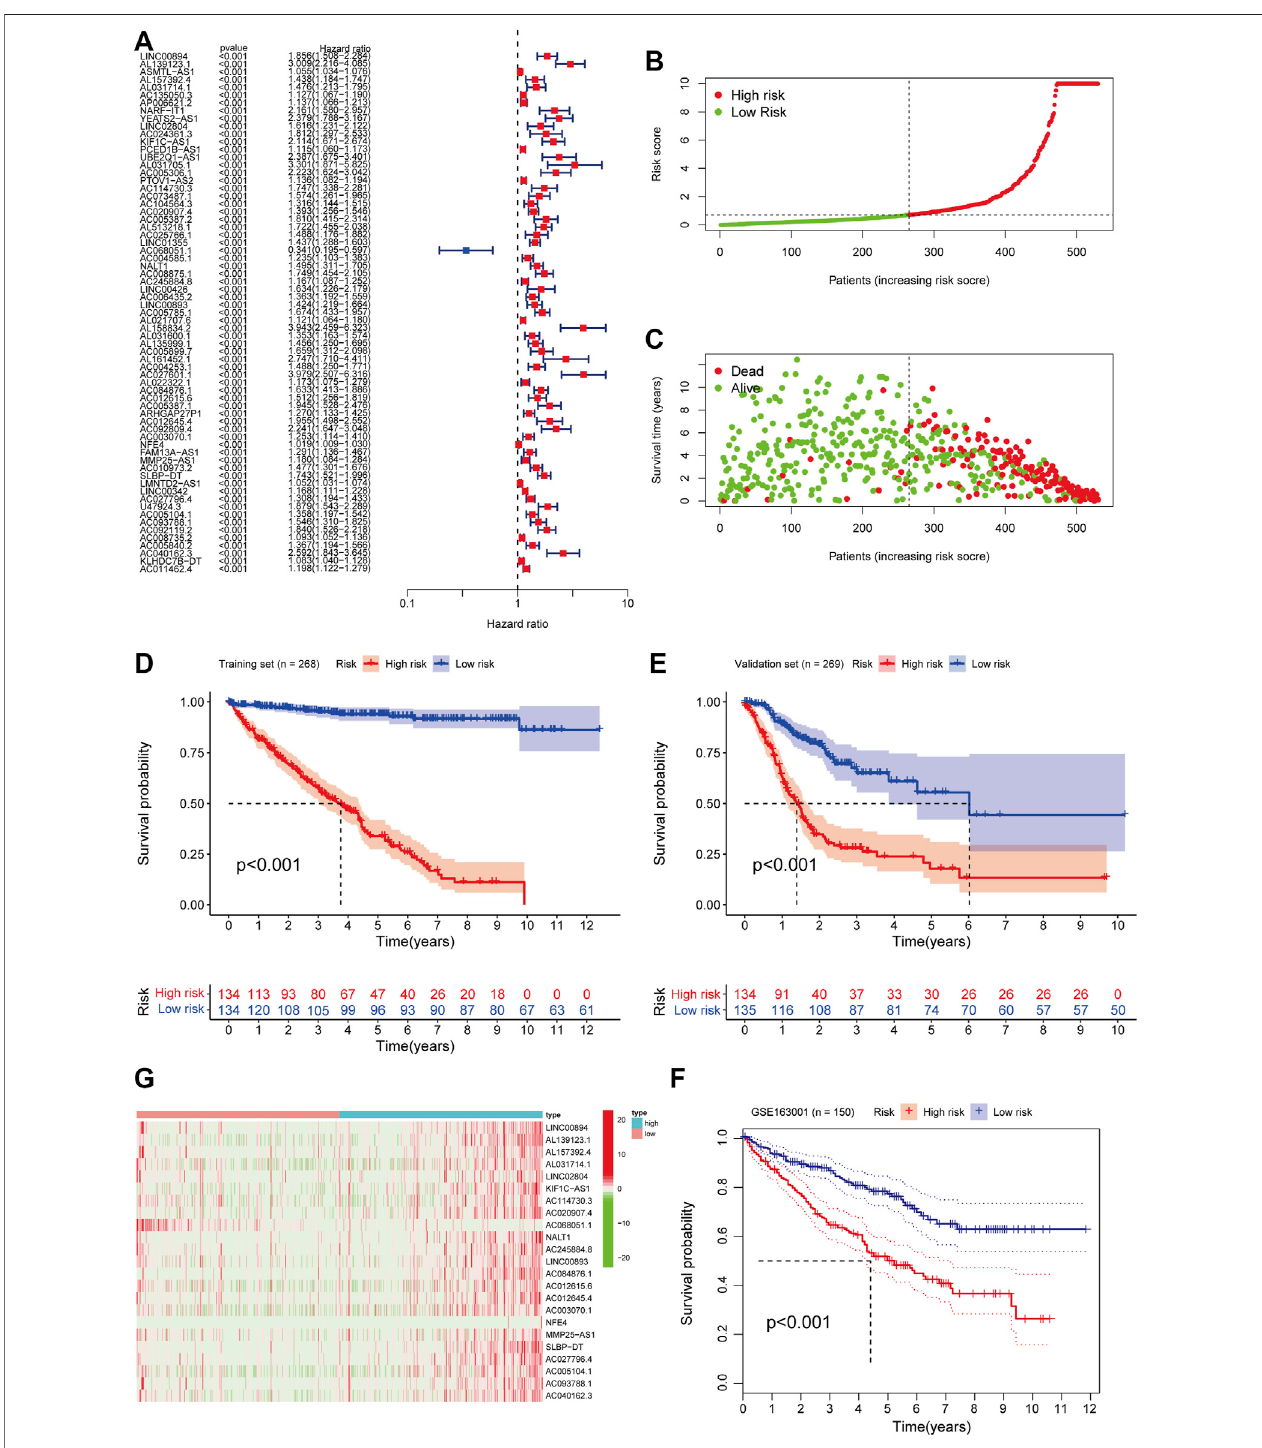
FIGURE2| Construction and validationofFRLs Prognostic Signaturein ccRCC patients. (A) Univariate Coxregressionanalysisshowed thatFRLswererelated to theOSofccRCCpatients. (B) Thedistribution ofriskscoresforthehigh-riskandlow-riskgroupsinccRCCpatients. (C) TheScatterplotsoftheOSinlower-riskccRCC patients and high-risk groups. (D) Survival curve of the high- and low-risk groups in the training set ( n = 268). (E) Kaplan-Meier survival curve of validation set ( n = 269) comparingthehigh-andlow-riskgroups. (F) Kaplan-MeiersurvivalcurveanalysisintheindependenttestsetGSE163001( n =150)comparingtworiskgroups. (G) Heatmap of clinical correlation of FRLs in ccRCC. All the K-M survival analyses use log-rank tests to determine signi fi cant differences between two groups, p < 0.05.